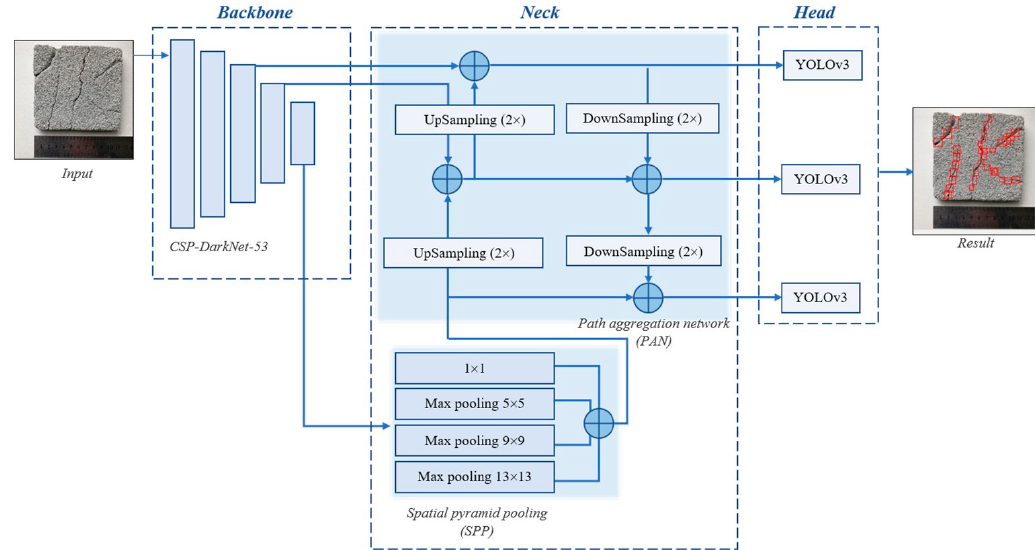
Figure 4. YOLOv4 architecture.